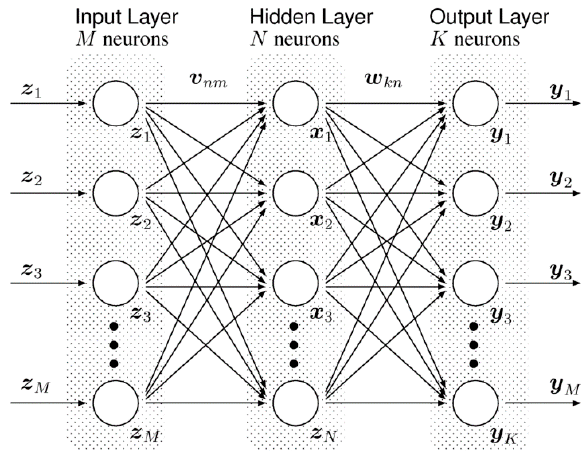
Figure 1. Typical structure of a multi-layer artificial neural network (ANN) [78] (the figure is free to be used as it is from an open access source).